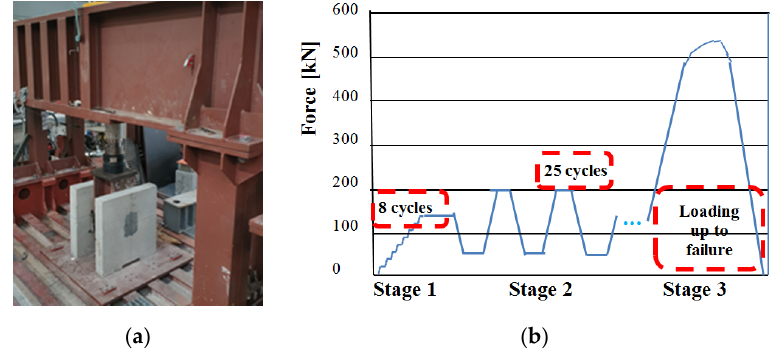
Figure 7. Layout of push-out specimen of RPC ( a ); loading procedure ( b ).